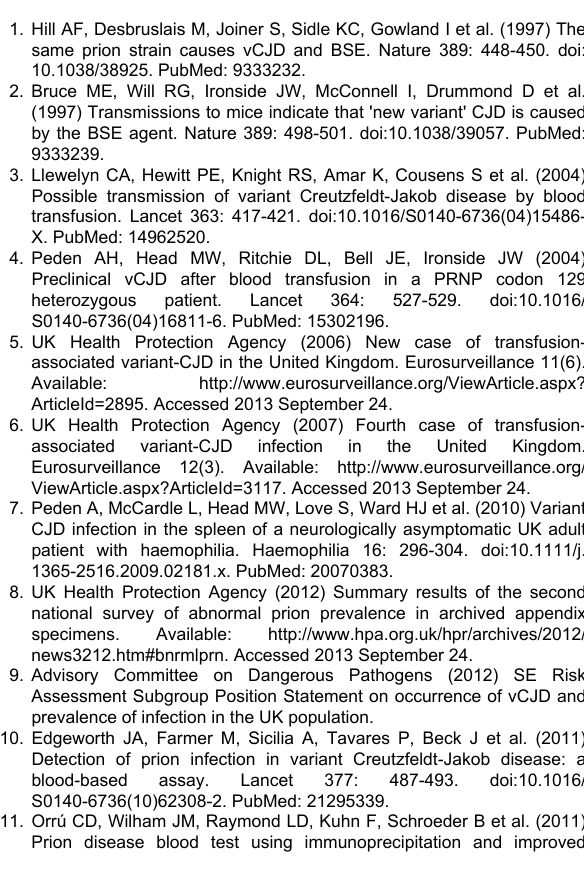
Table S1. Prion protein amino acid sequence alignment of red-backed vole ( Myodes gapperi ), meadow vole ( Microtus pennsylvanicus ), bank vole ( Myodes glareolus ), golden Syrian hamster ( Mesocricetus auratus ), cynomolgus macaque ( Macaca fascicularis ), and human ( Homo sapiens ). Amino acids at position 170, hypothesized to play